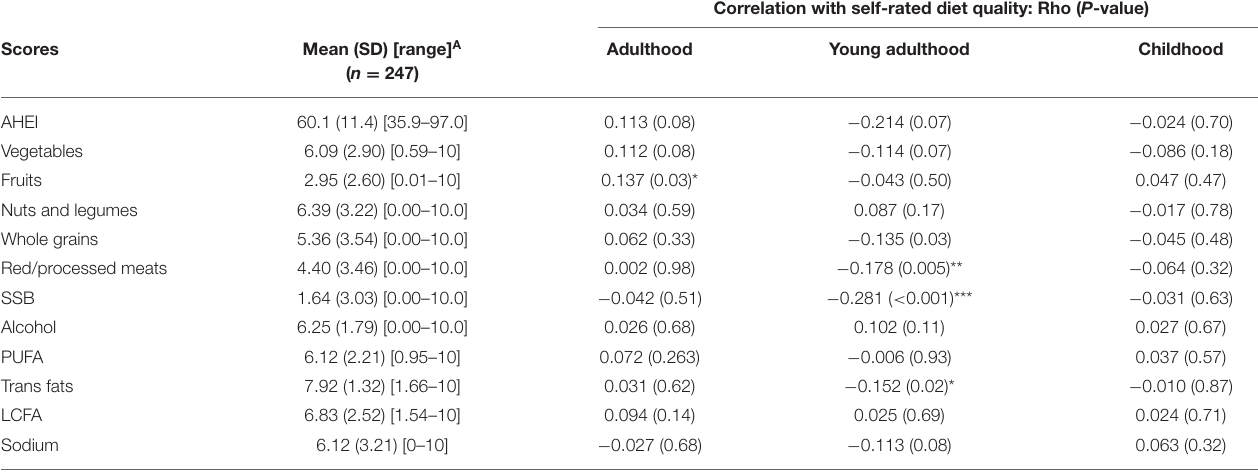
TABLE 3 | Correlation between Alternate Healthy Eating Index scores and self-rated current diet quality at three life stages (adulthood, young adulthood, childhood) on a five-point scale ( n = 247). Correlation with self-rated diet quality: Rho ( P -value) Scores Childhood